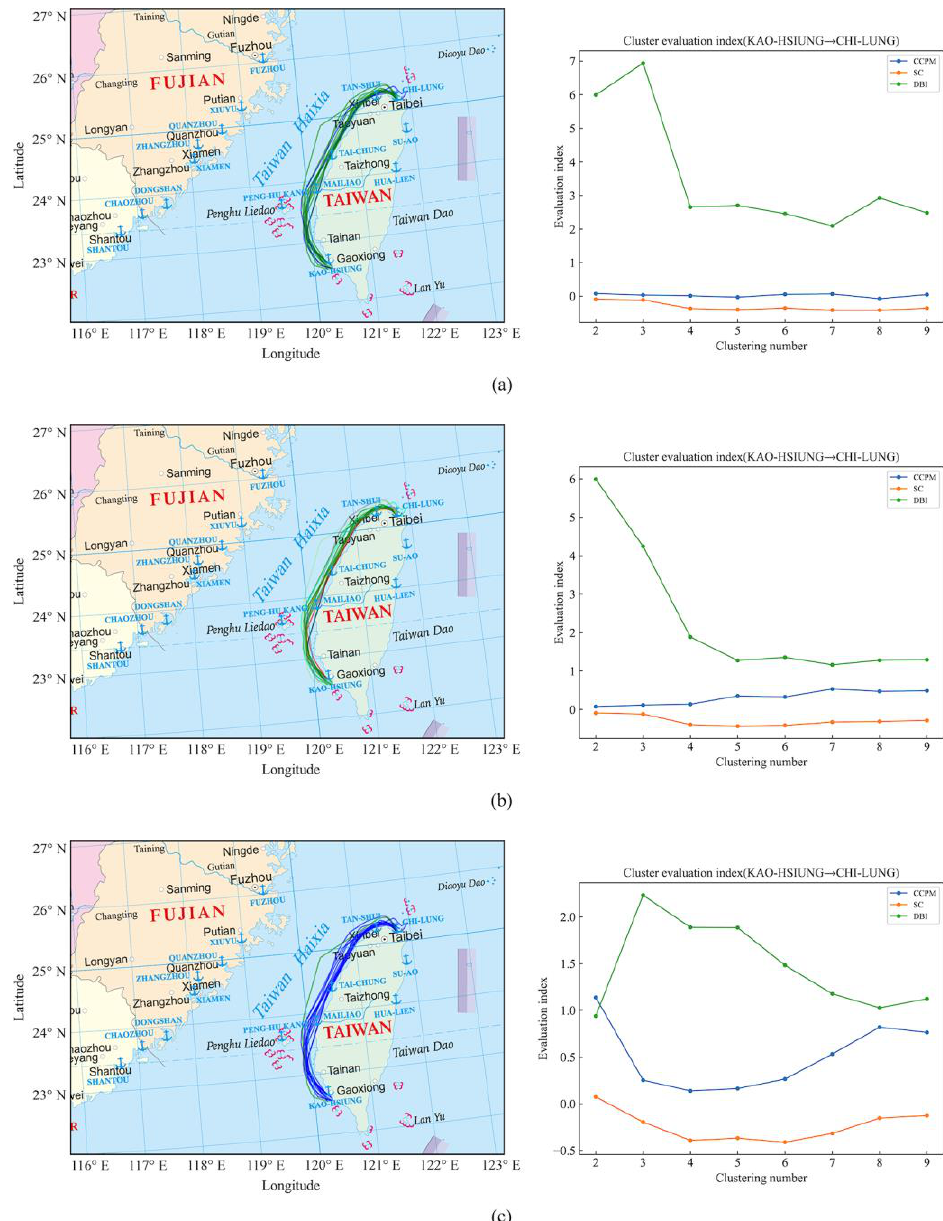
Figure 18. ( a ) K-Means clustering results and quantitative evaluation results of the ship trajectories from Kaohsiung Port to Keelung Port. ( b ) DBSCAN clustering results and quantitative evaluation results of the ship trajectories from Kaohsiung Port to Keelung Port. ( c ) BIRCH clustering results and quantitative evaluation results of the ship trajectories from Kaohsiung Port to Keelung Port.